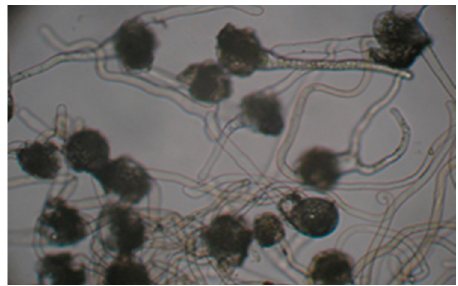
Figure 3. Dryopteris affinis —germinated spores: Control, ×100.